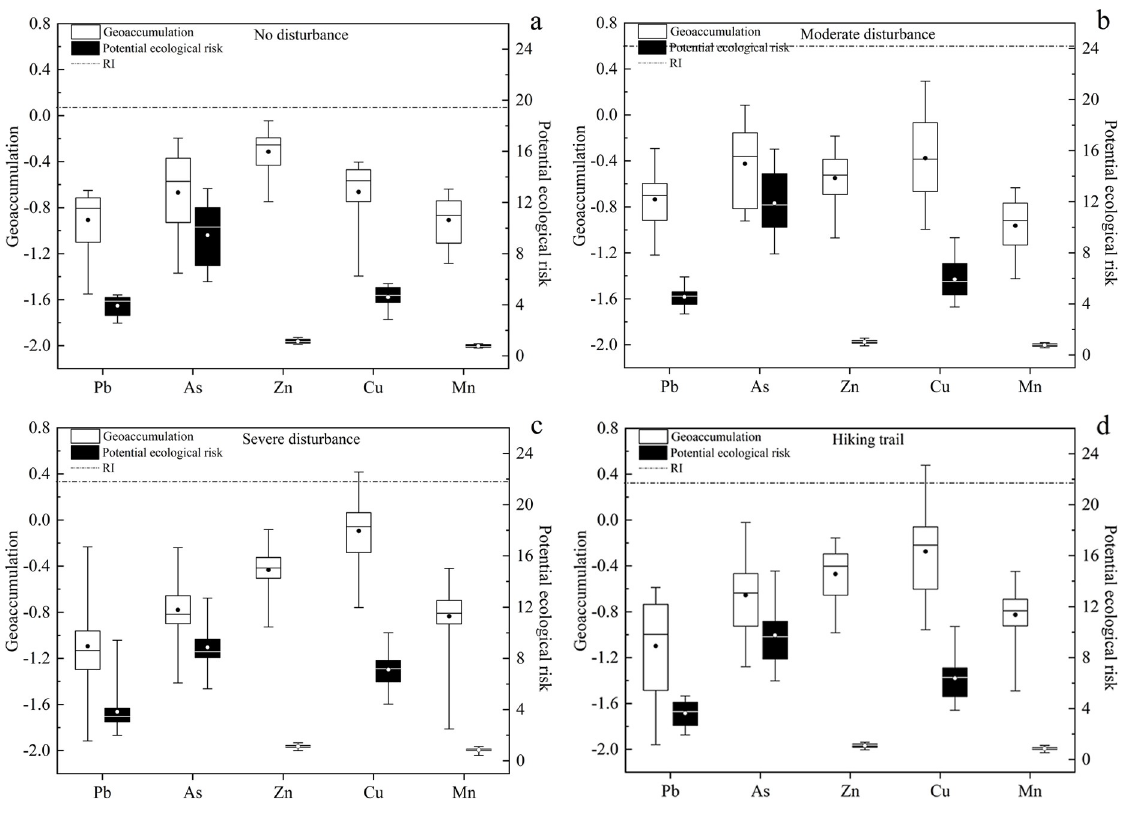
Fig 5. Geoaccumulation and potential ecological risk of soil heavy metal in Lujiaowan Scenic Area.